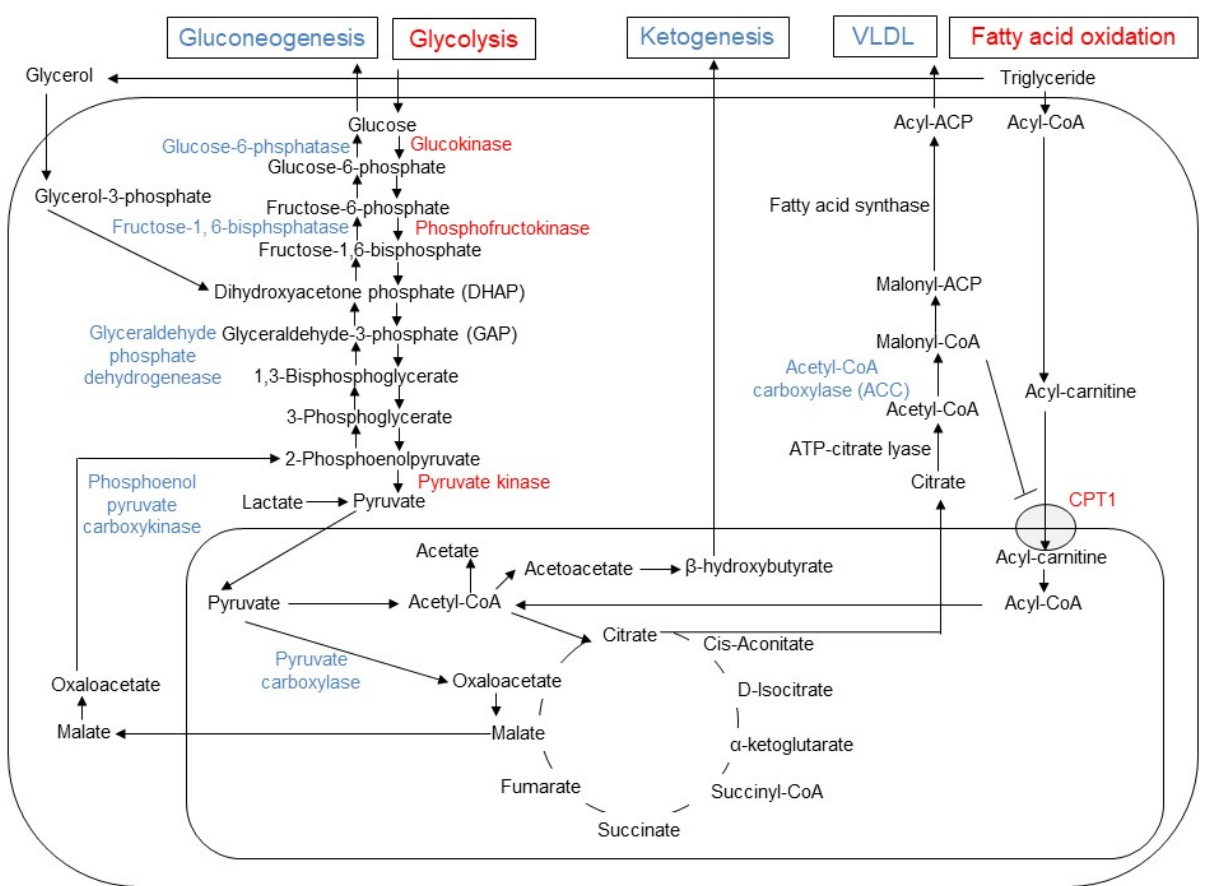
Figure 2. Changes in gluconeogenesis, glycolysis, lipogenesis, fatty acid oxidation, and ketogenesis induced by metformin in hepatocyte. In hepatocytes, metformin enhances glycolysis and fatty acid oxidation, while it inhibits gluconeogenesis, ketogenesis and release of very low-density lipoprotein (VLDL). The enzymes with enhanced activities are indicated by blue, while the reduced enzymes by red font. Since malonyl-CoA inhibits the activity of carnitine palmitoyltransferase 1 (CPT1), the reduced activity of acetyl CoA carboxylase (ACC) results in increased influx of acyl-carnitine into mitochondria and fatty acid oxidation by